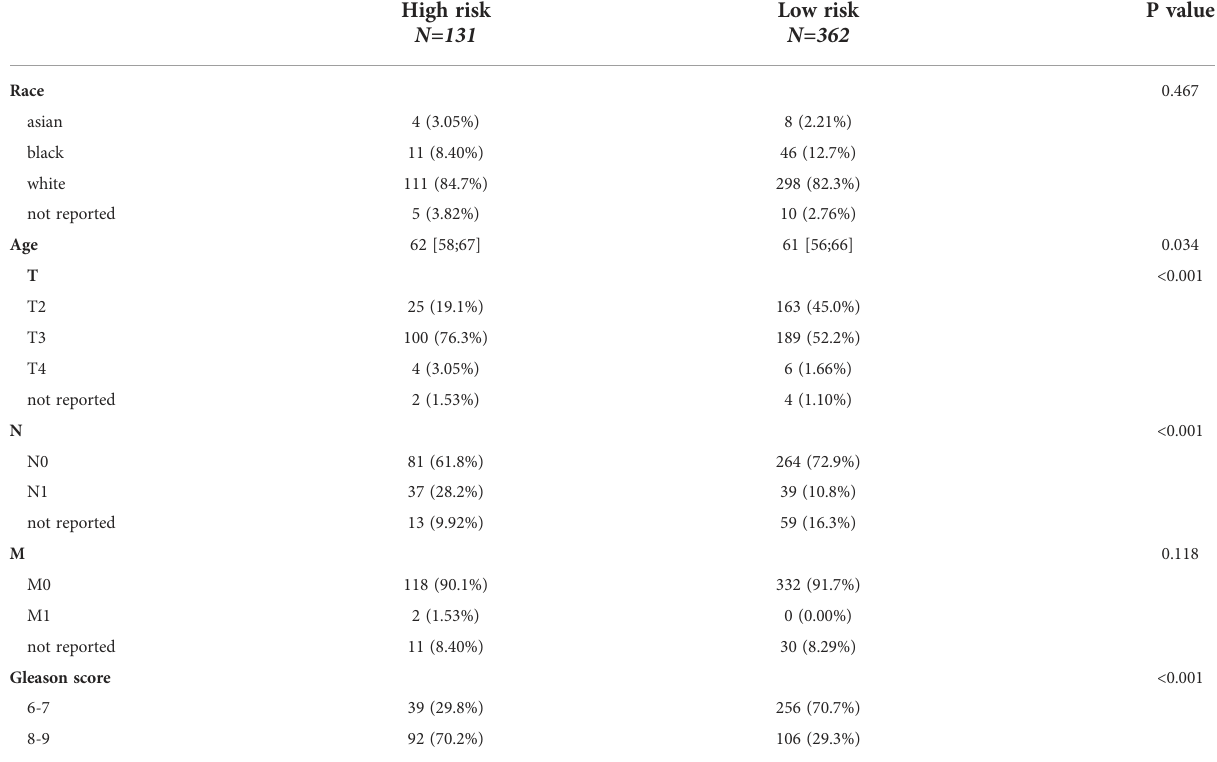
TABLE 1 Clinical features of TCGA